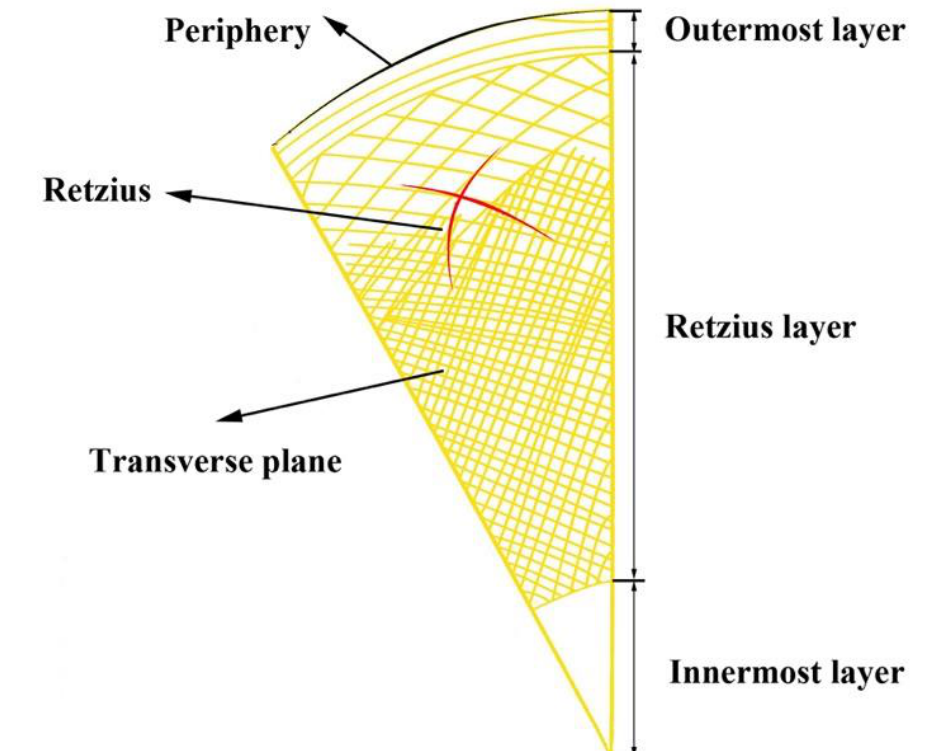
Figure 2. Schematic diagram of Retzius. This pattern consists of alternative light and dark lines interweaving to form a network, which begin at the center of the tusk and sweep outwards to the periphery.